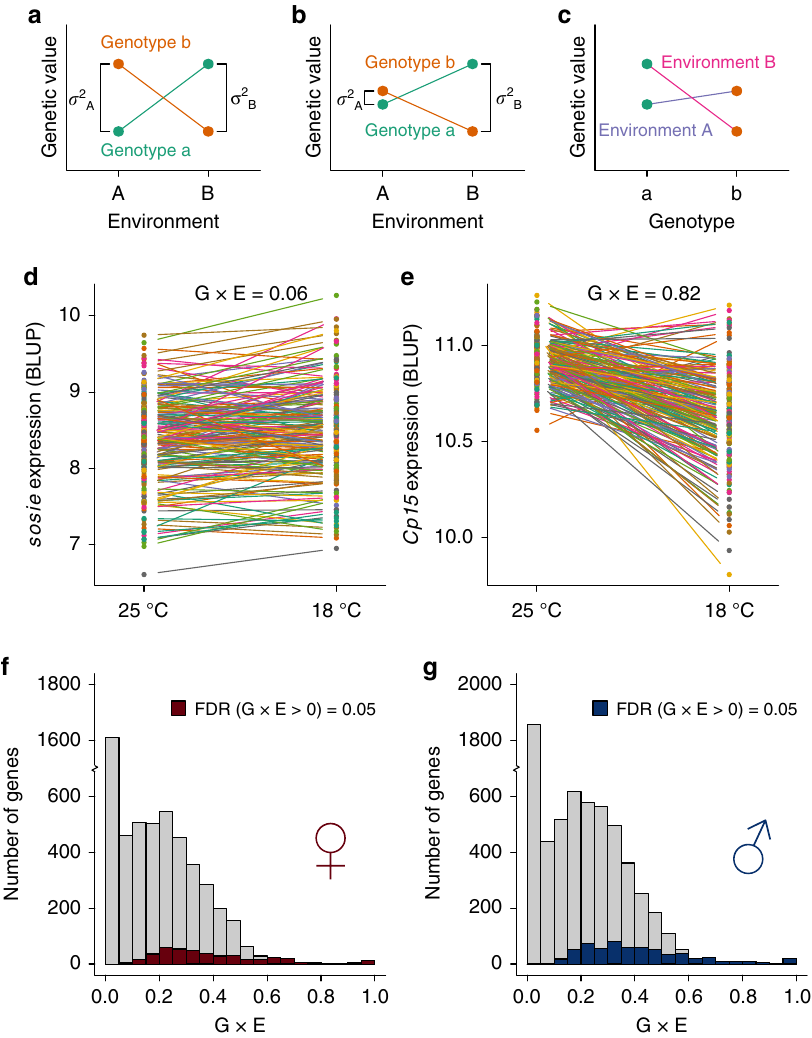
Fig. 3 Genotype by environment interaction (G×E) of gene expression. a Reaction norms between environment A and B for two genotypes a and b. Points of the same color represent the same genotype; the slope of the lines connecting points of the same color indicate the magnitude of the change in genetic value for that genotype between the two environments. Signi fi cant differences in slope for different genotypes signify the presence of G×E. In this example, there is G×E but no change in genetic variance between the two environments. b No mean effect of temperature but signi fi cant G×E and change in genetic variance between the two environments. c The same data as in b but plotted with respect to difference between genotypes across the two environments. d Example of a gene ( sosie ) in females with low degree of G×E. e Example of a gene ( Cp15 ) with a high degree of G×E in females. G×E is de fi ned as = ð σ 2 þ σ 2 Þ . f Distribution of G×E for genes in females, where signi fi cant genes are marked by dark red color. g Distribution of G×E for genes in G ´ E ¼ σ 2 GE GE G males, where signi fi cant genes are marked by dark blue